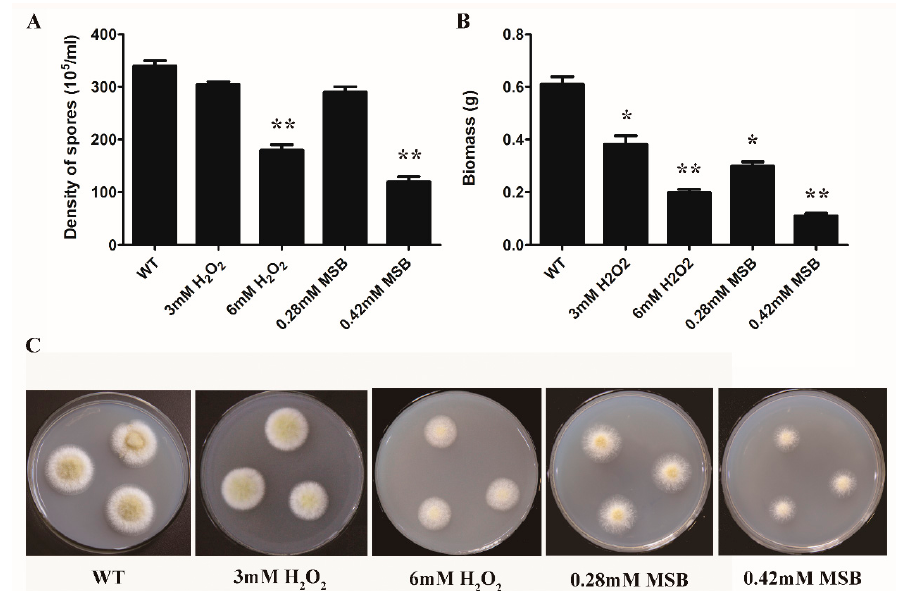
Figure 1. The density of spores, dry biomass and phenotype as affected by oxidative treatment. ( A )